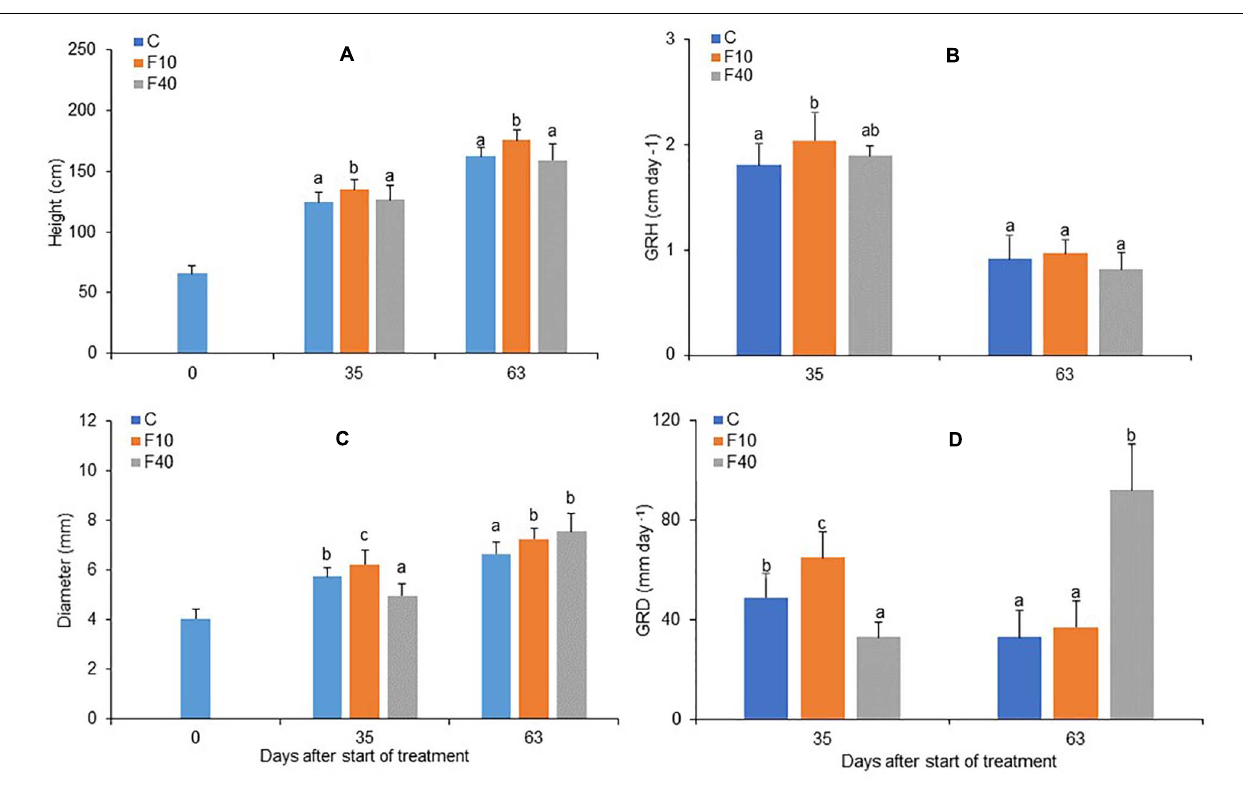
( Figure 3B , day 35). The growth rate in diameter (GRD) differed significantly among treatments, F40 had the lowest rate, while F10 had the highest ( Figure 3D , day